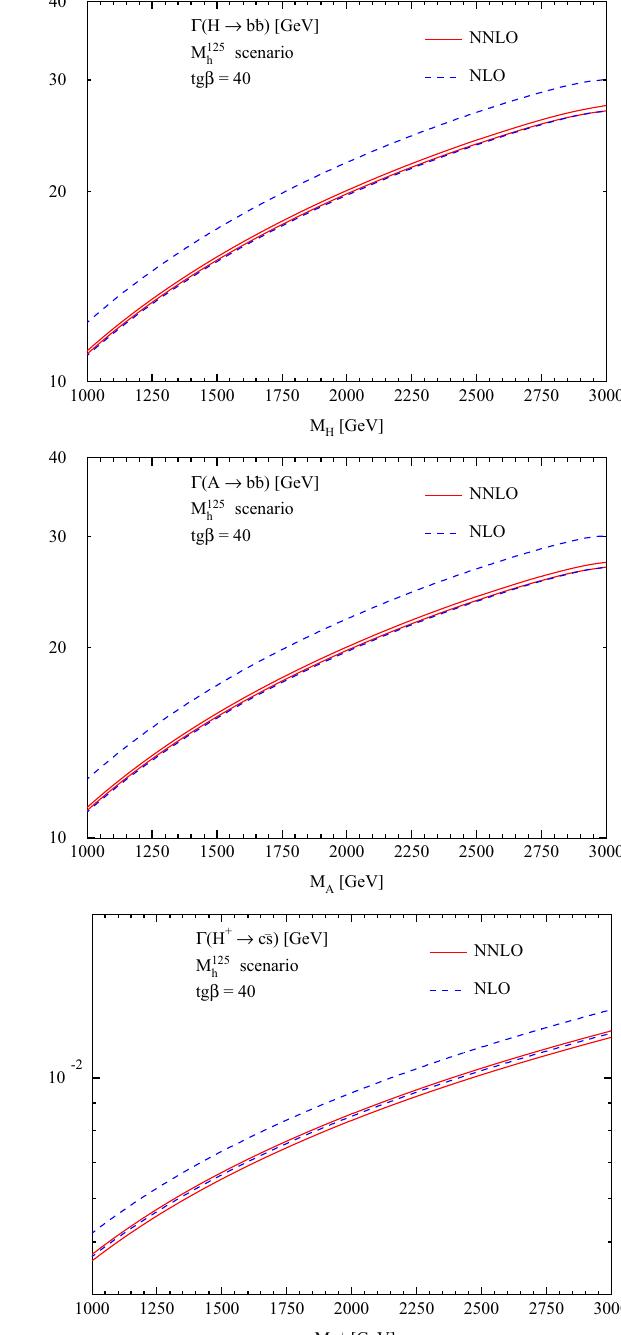
Fig. 10 Partial decay widths of the heavy scalar H and the pseu- doscalar A Higgs bosons to b ¯ b (upper two plots) and charged Higgs decays to c ¯ s (lower plot) in the M 125 scenario. The dashed blue bands h display the scale dependence at the one-loop level and the full red bands at the two-loop level by varying the renormalization scales of (cid:9) b and (cid:9) / 3 and 3 times the central scale fixed by the average of s between 1 the involved SUSY-particle